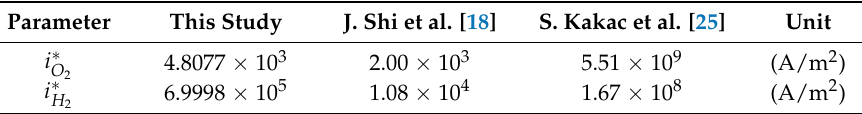
Table 5. Comparison of reference exchange current density with literature.